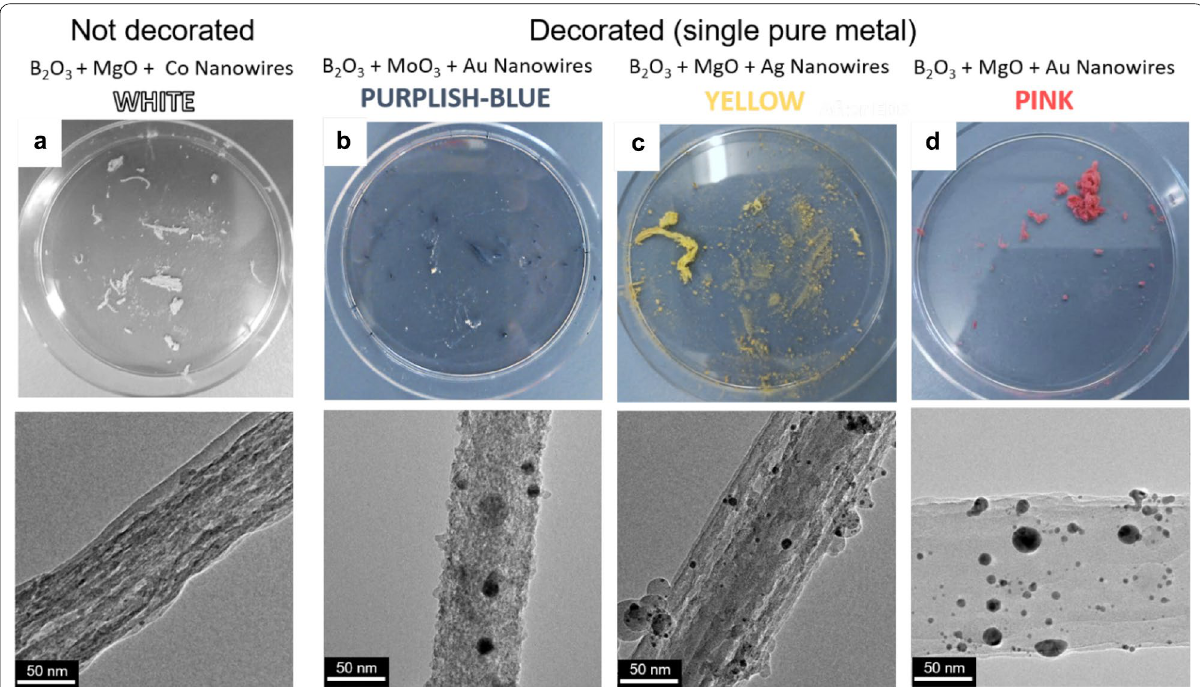
Fig. 3 Nanowires with different colorations. The synthesis rounds tend to produce macroscopic amounts of nanowires with distinct colorations which depend on the composition of the ablated pellets. a A photograph of the white product from an ablated target containing B 2 O 3 :MgO:Co. The TEM micrograph below reveals that these nanowires are not decorated with nanoparticles. b – d Photographs of nanowires fabricated from targets containing, B 2 O 3 :MoO 3 :Au, B 2 O 3 :MgO:Ag and B 2 O 3 :MgO:Au, their colors are bluish gray, yellow and pink respectively. A TEM micrograph of each type of nanowire is right below each photograph. They all show that these nanowires are decorated with nanoparticles. By mixing more than one